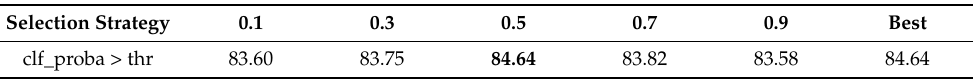
Table 11. The F1 scores produced by a pipeline that uses classifiers trained with semi-supervised learning when working on the data from the 2020 SHL